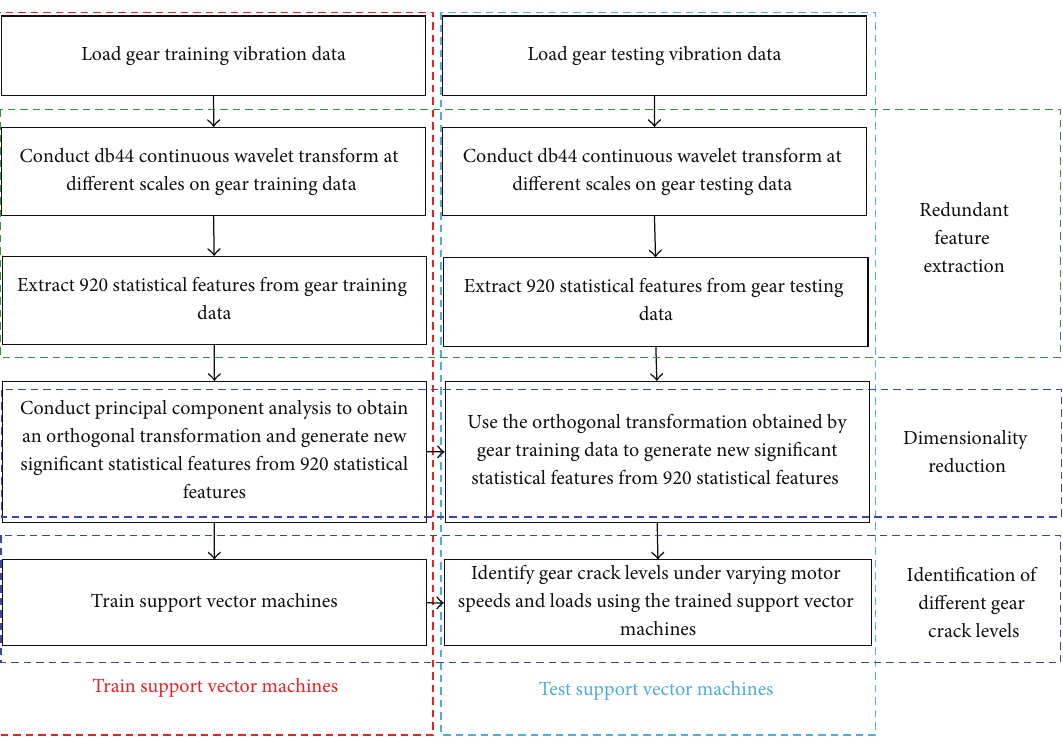
Figure 1: The flowchart of the proposed method for identification of different gear crack levels under different motor speeds and loads.